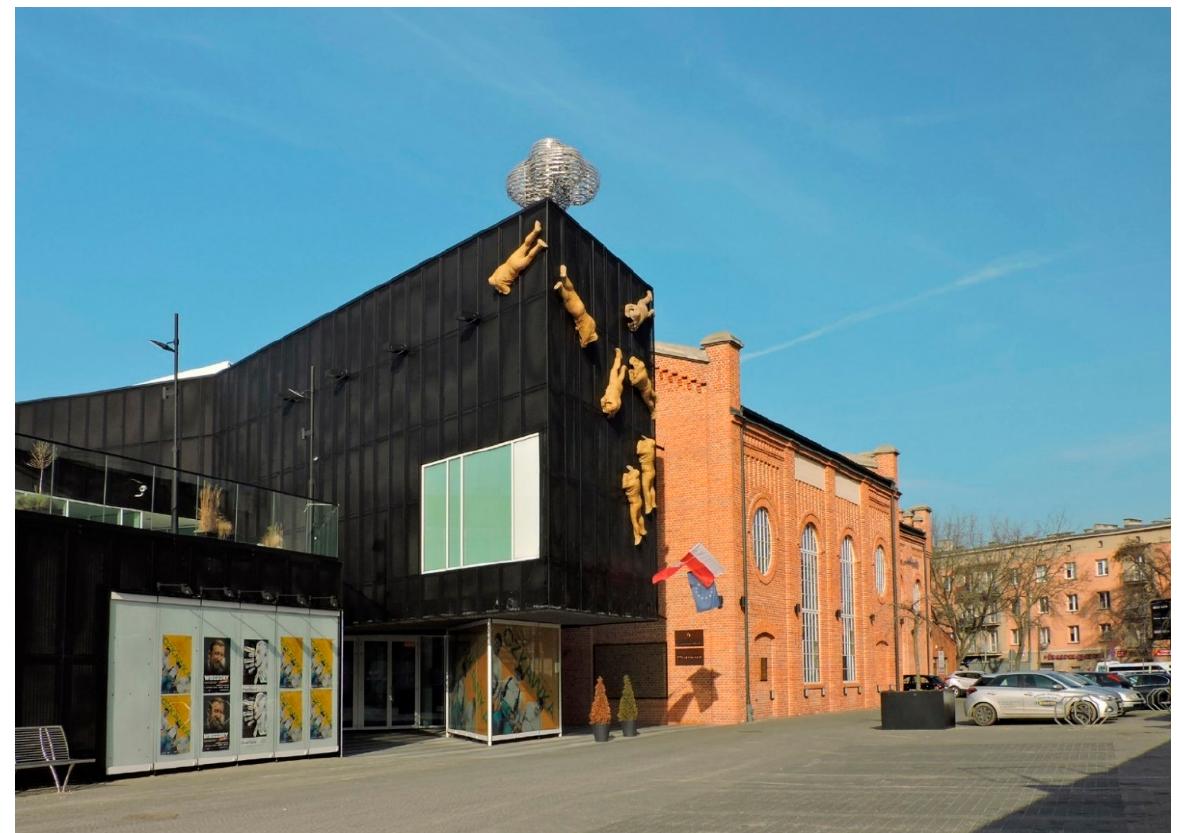
Figure 9. Mazovia Centre for Contemporary Art “Elektrownia” in Radom, photo by Rafał Terkner, Wikimedia Commons, available online: https://upload.wikimedia.org/wikipedia/commons/f/f4/Centrum_Sztuki_Wspolczesnej_Elektrownia_ 1549766_Fotopolska-Eu.jpg (accessed on 24 September